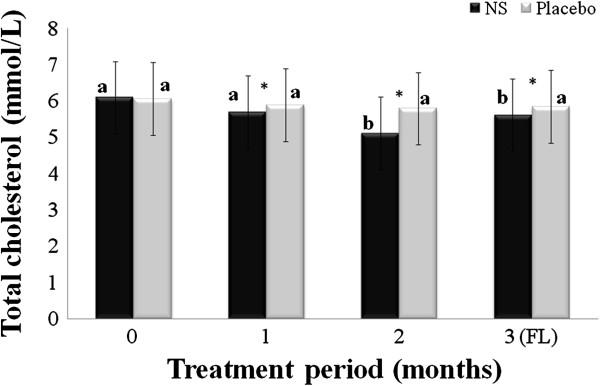
Changes in serum total cholesterol (TC); menopausal women randomly assigned to Nigella sativa (N.S) or placebo groups were treated for 2 months and blood samples taken at baseline, and 1 and 2 months after the start of the intervention, and one month after cessation of intervention (FL), and used to evaluate serum TC. Results are expressed as mean ± SD. *significant between N. S vs. placebo group at p < 0.05. Different letters on bars representing different intervals for the same group indicate significant difference between the intervals for the same treatment (p < 0.05).